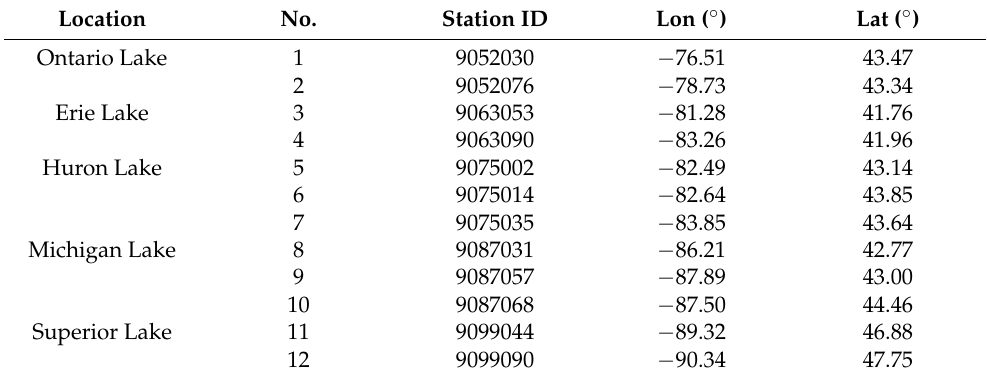
Table 1. Table of details of hydrological stations in the study area used as accuracy verification.